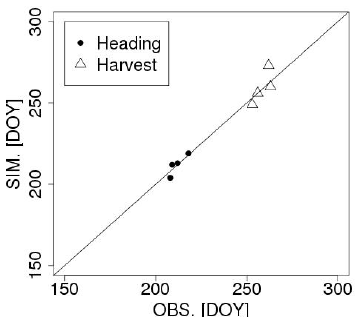
Figure 1. Comparison of heading and harvest dates. SIM: simula- tions; OBS: observations; DOY indicates the number of days from 1